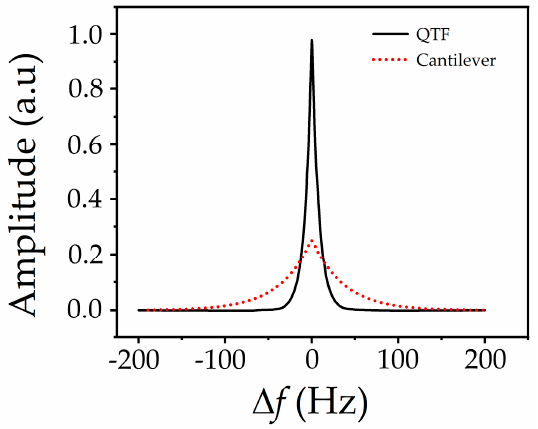
Figure 6. Q values of the QTF probe and the cantilever beam probe.